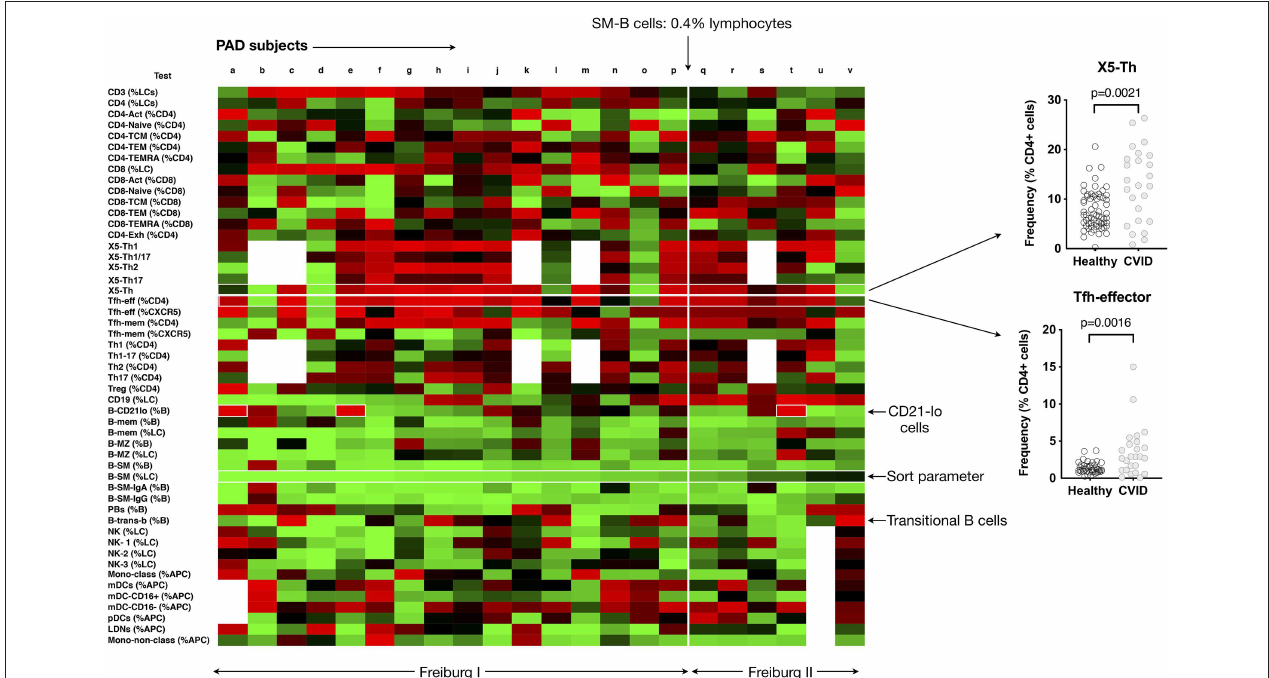
FIGURE 3 | Heat mapping with continuous color shading (as depicted in Figure 2A ) in PAD patients. Heat maps from individual patients (labeled a to v) are ordered from left to right based on increasing proportions of switched memory B cells (B-SM), with the cut-off of 0.4% of total lymphocytes shown. The expansion of CD21-lo B cells can be readily appreciated (labeled), as can the expansion in CXCR5 + /CD45RA–CD4T cells (X5-Th), and Tfh-effector cells and (as a percentage of CD4T cells). Inset shows the comparisons between control values ( n = 77) and PAD patients for X5-Th and Tfh-effector cells. Details of PAD patients presented in Supplementary Table 2